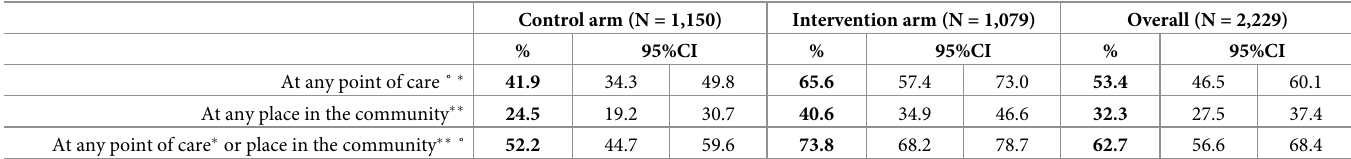
Table 6. Information on child complementary feeding received at a health facility and in the community per trial arm and